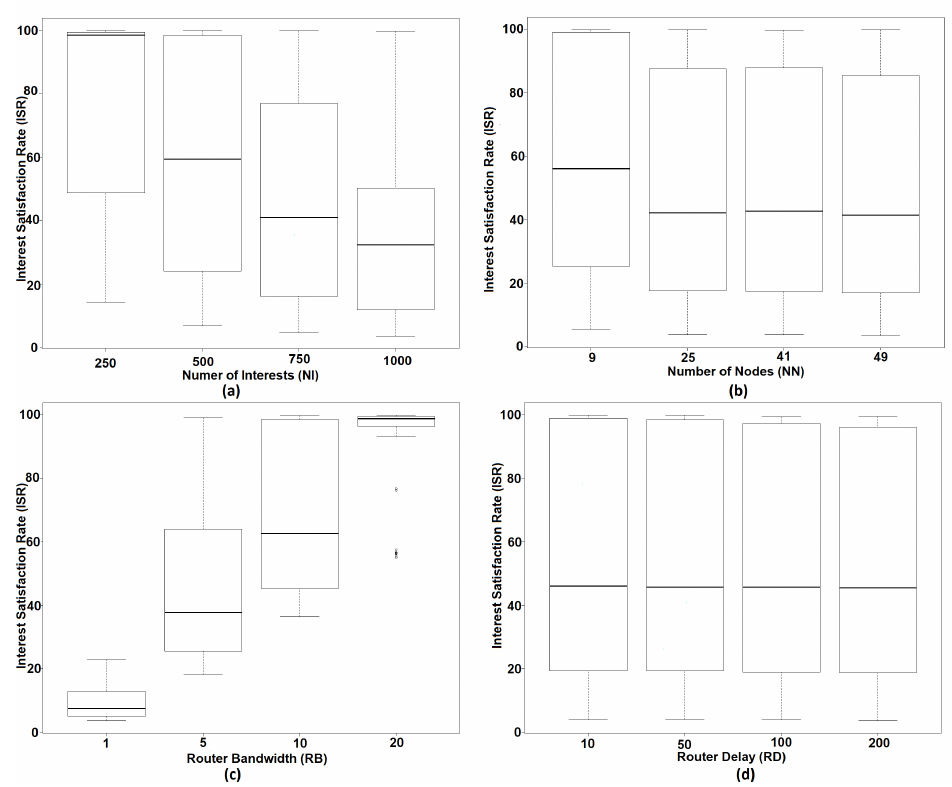
Figure 4. Mean plot for the main effect: ( a ) ISR as a function of the number of interest (NI), ( b ) ISR as a function of number of nodes (NN), ( c ) ISR as a function of router bandwidth (RB), and ( d ) ISR as a function of router delay